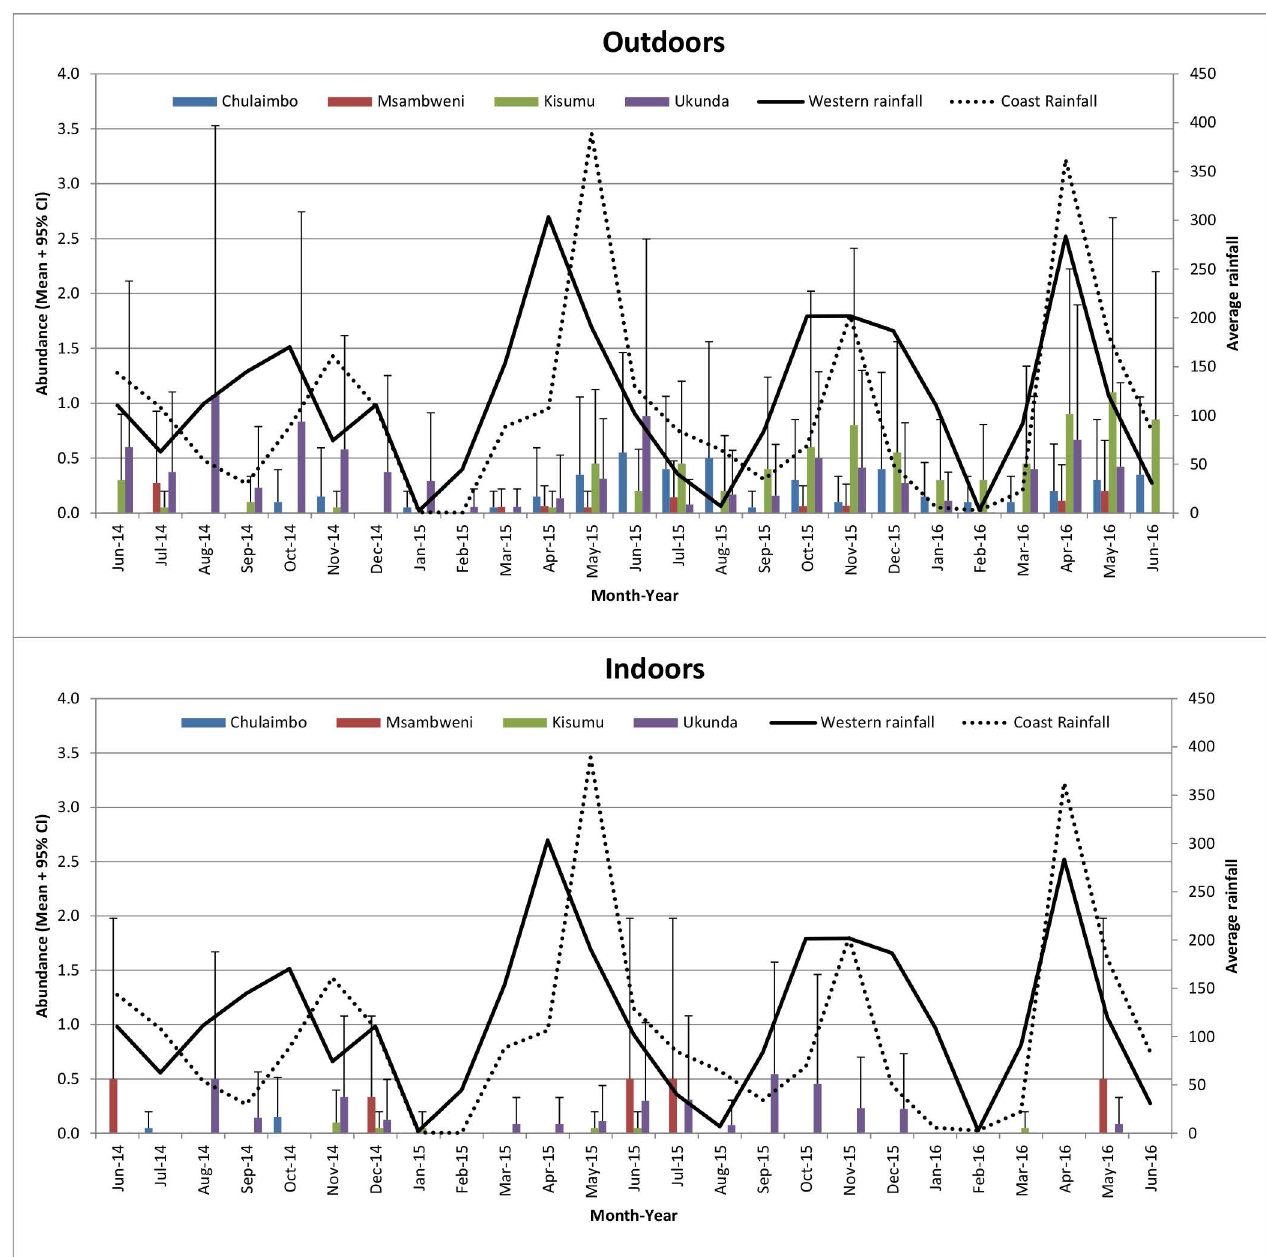
Fig 3. Mean numbers + 95% CI of Aedes aegypti mosquitoes collected by Prokopack aspirators.